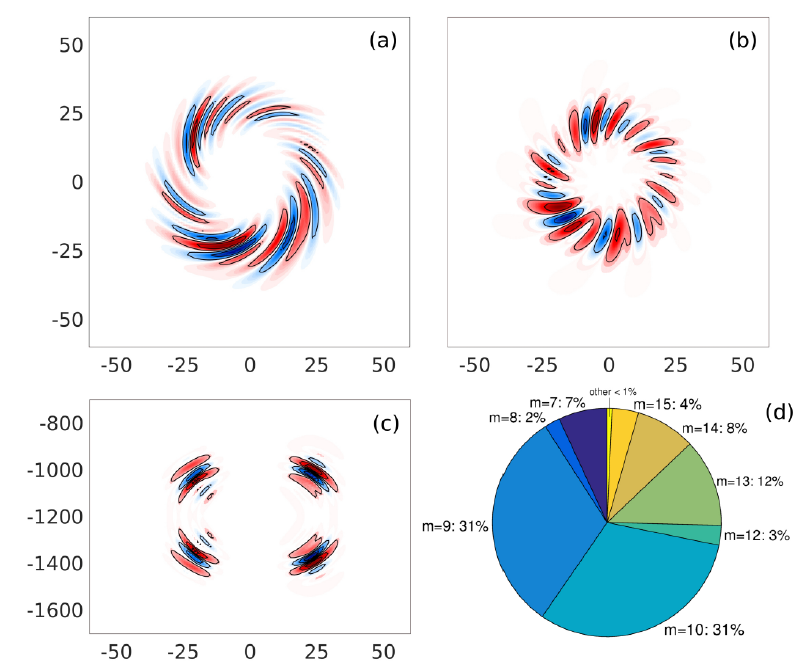
Figure 2. Optimal perturbation for the time interval τ = 4 days. ( a ) PVA horizontal section through the vortex core. ( b ) PVA section through the vortex lobes. ( c ) PVA vertical section. ( d ) Energy distribution on the azimuthal modes.